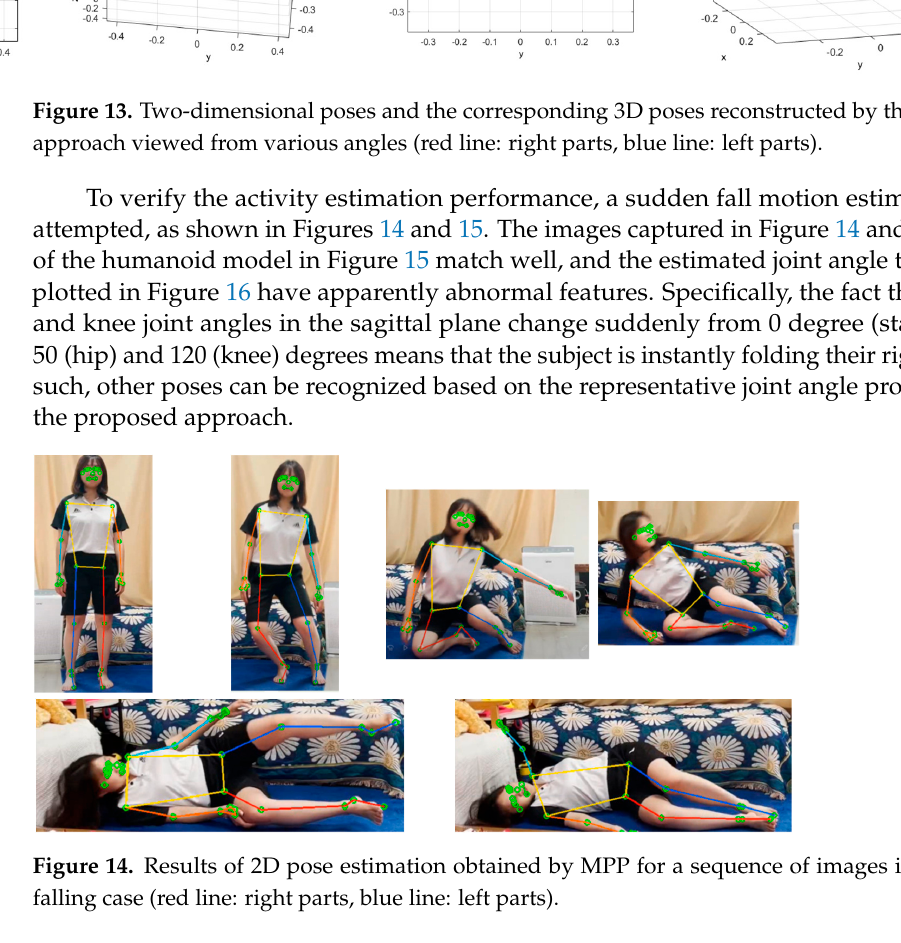
Figure 14. Results of 2D pose estimation obtained by MPP for a sequence of images in a sudden falling case (red line: right parts, blue line: left parts).